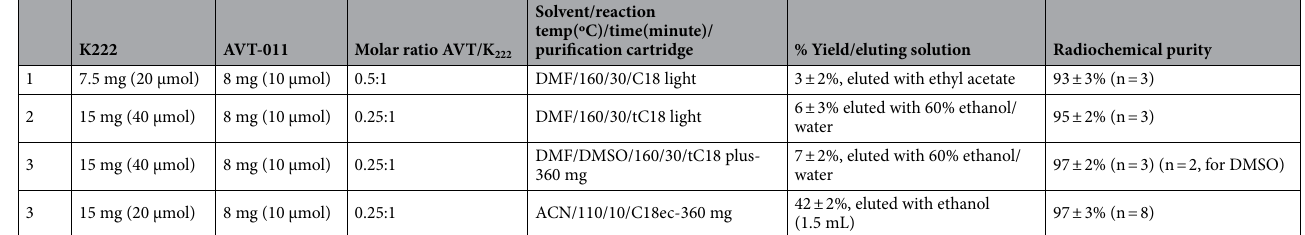
Table 1. Showing different combinations to standardize the method yielding high radiochemical purity and yield.